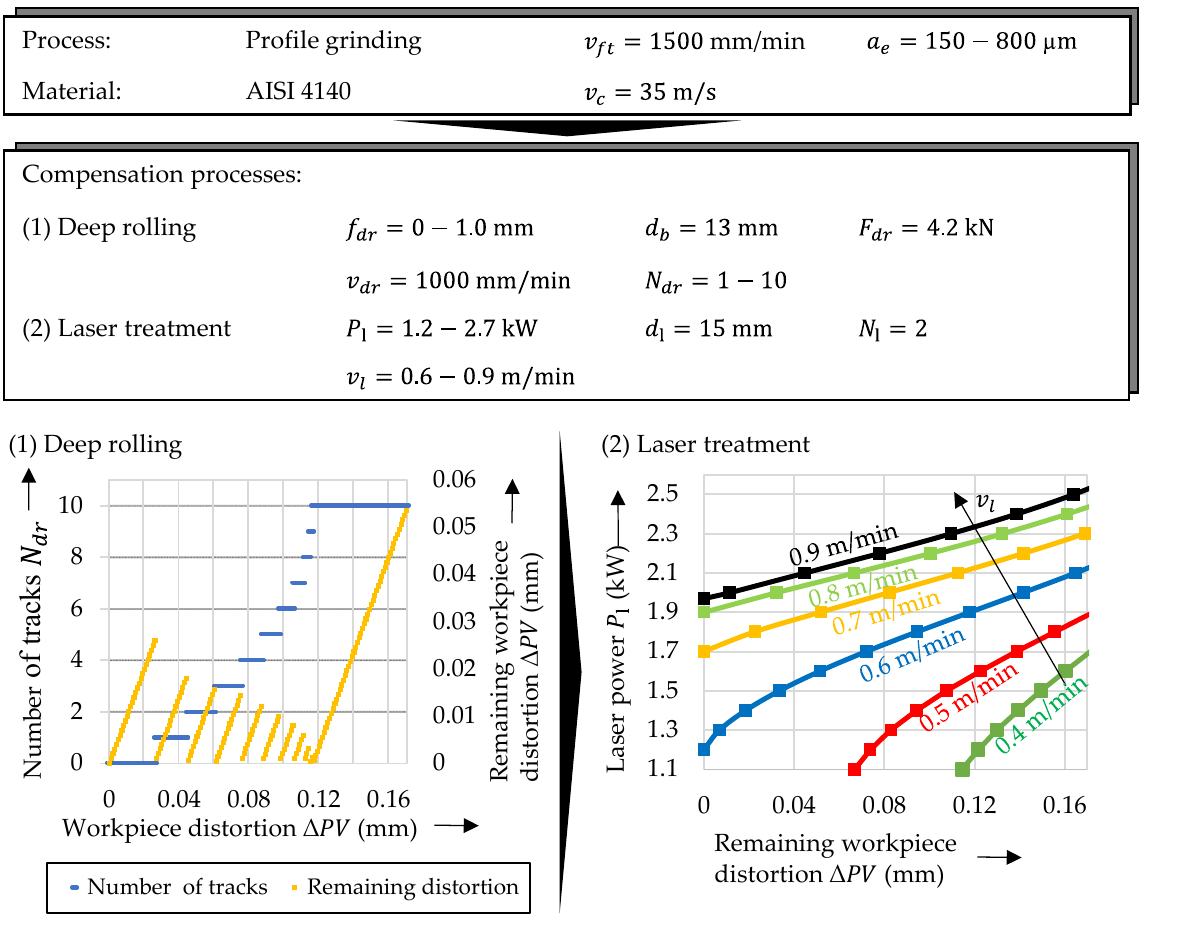
Figure 8. Distortion compensation strategy by multi-pass deep rolling (1) with a different number of tracks N dr , leaving a distortion, and by a following laser treatment (2) for different laser powers P l and laser feed rates v l (optimal parameters) for workpieces ground at a constant feed rate of 1500 mm/min and depths of cut between 150 and 800 μ m.